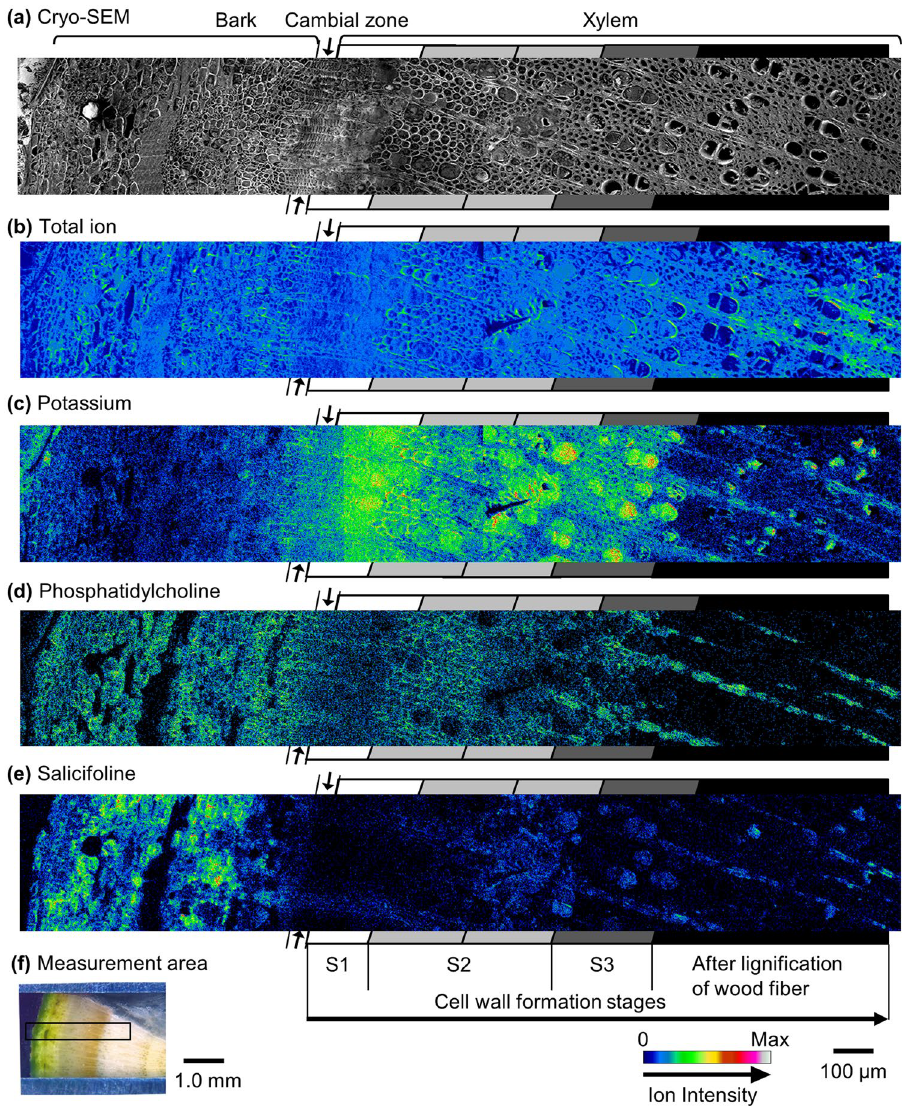
Figure 3. Transverse surface images of freeze-fixed M. kobus visualized by cryo-TOF-SIMS/SEM. ( a ) Cryo- SEM image taken after cryo-TOF-SIMS measurement and appropriate freeze etching. Cryo-TOF-SIMS positive ion images of the ( b ) total ion, ( c ) potassium, ( d ) phosphatidylcholine, and ( e ) salicifoline. ( f ) Optical microscopic image of a freeze-fixed stem of M. kobus in a sample holder showing the measurement area (approximately 2.4 × 0.4 mm). Scale bars are 100 μ m for a, b, c, d, and e and 1.0 mm for f. Arrows above and below the sides of the images of a, b, c, d, and e indicate the cambial zone. Grey scaled tetragons at both sides of the images a, b, c, d, and e indicate the cell wall formation stages of wood fibres.